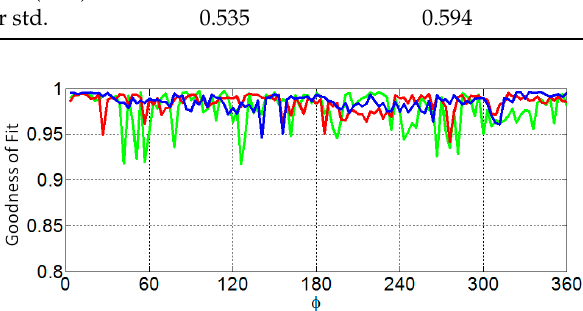
Figure 7. Goodness of fit of profile as the azimuth angle varies for models A (blue), B (red), and C (green).